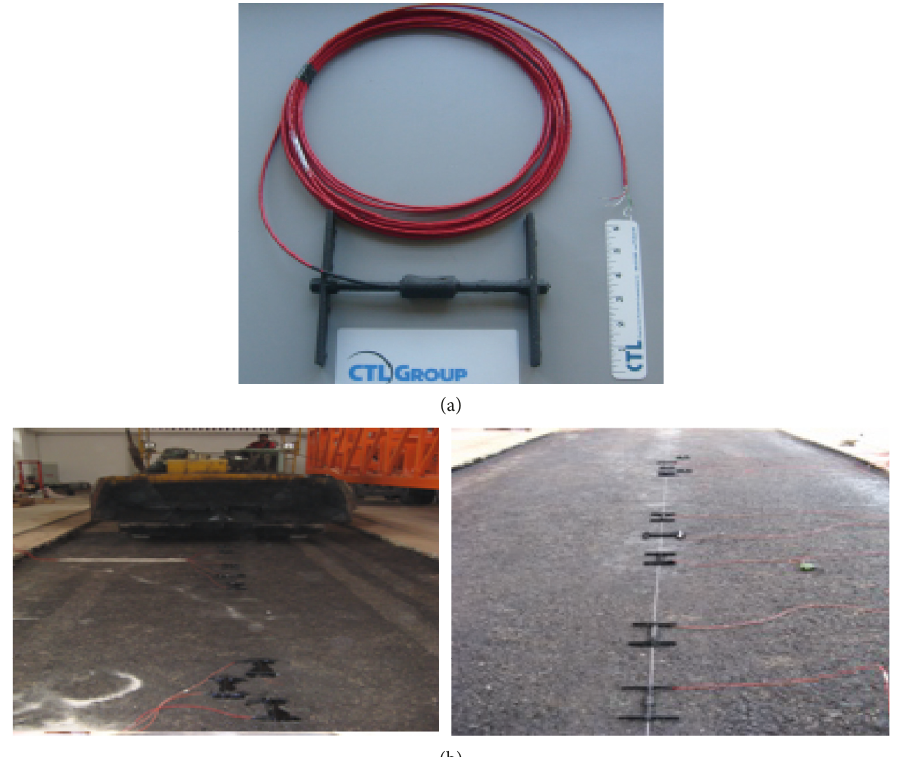
Figure 8: Asphalt strain sensor model ASG-152: (a) photograph and dimension of ASG-152; (b) ASG-152 layout.